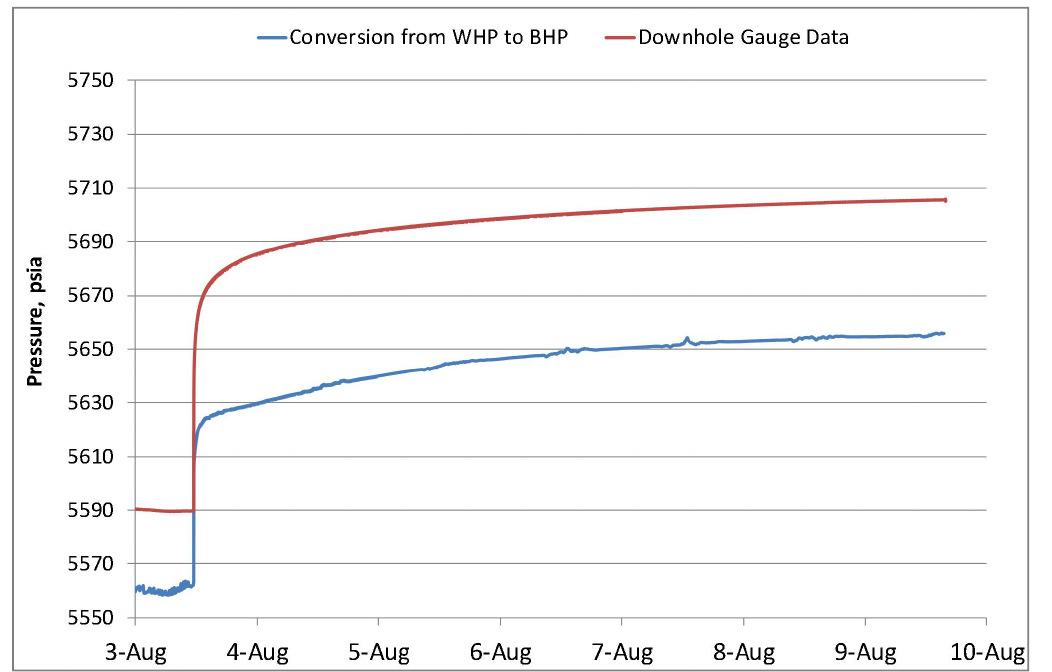
Figure 8—BHP conversion vs. downhole gauge measurement before thermal decay model